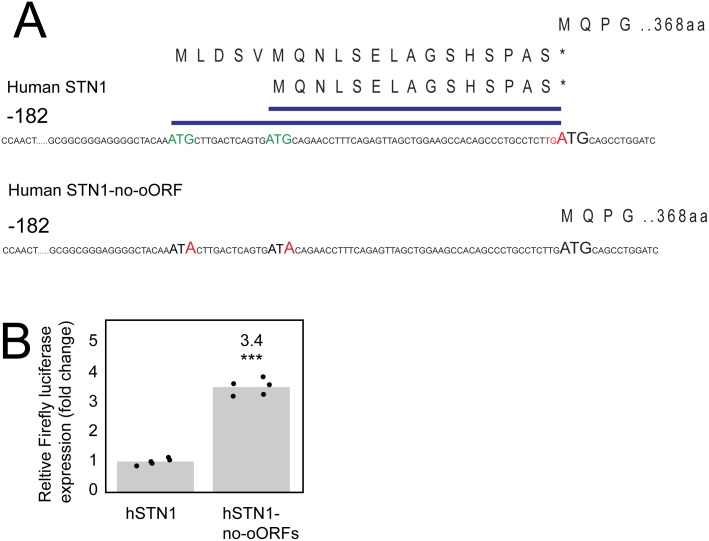
Human Stn1 has two oORFs that reduce expression.A) Sequences of human STN1 transcript leader indicating the positions of the oORFs. B) Dual luciferase assay of STN1 driven URS expression in human cells. HCT116 cells were transfected with pGL3 expressing FLuc under the control of STN1 or STN1-no-oORF TLs. Co-transfected pRL-TK expressing RLuc was used as a normalization control. Values are normalized to the loading control and calculated relative to STN1 as in Fig 1B. Each point represents a measurement from an independent transfection. P values were calculated using an unpaired t-test (***) P < 0.001.